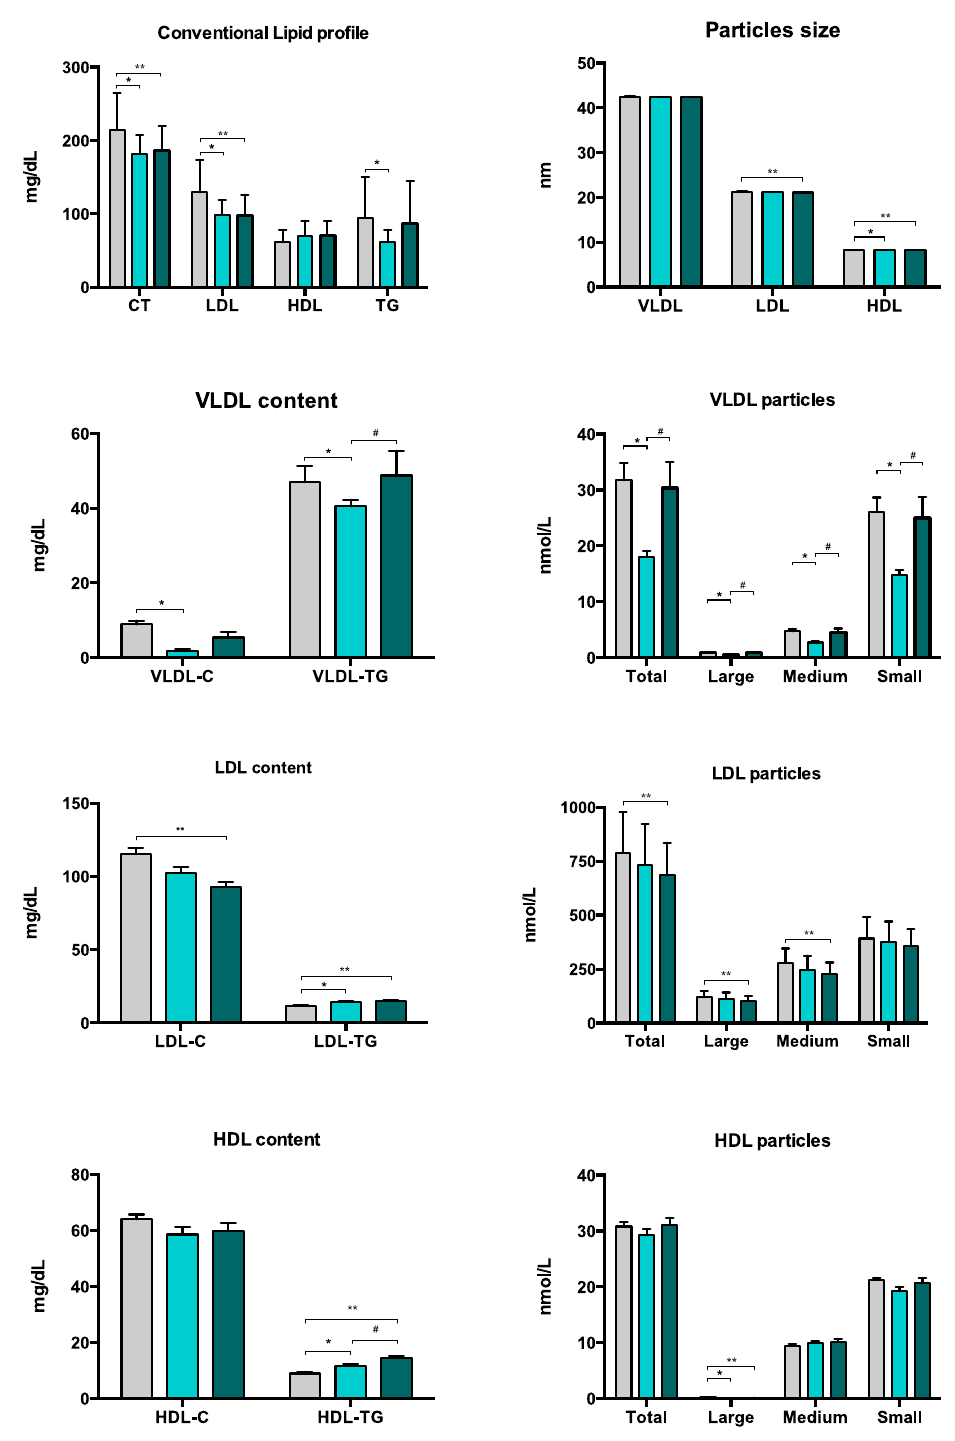
Figure 3. Conventional lipid profile and NMR-assessed lipoprotein subclass profiles for healthy participants (grey) and participants with T1DM according to the absence (light green) or presence (dark green) of arterial sti ff ness. * p < 0.05 for participants with T1DM without increased arterial sti ff ness vs. healthy participants, ** p < 0.05 for participants with T1DM with increased arterial sti ff ness vs. healthy participants, and # p < 0.05 for participants with T1DM with increased arterial sti ff ness vs. participants with T1DM without increased arterial sti ff ness. HDL: high-density lipoprotein; LDL low-density lipoprotein; VLDL: very-low-density